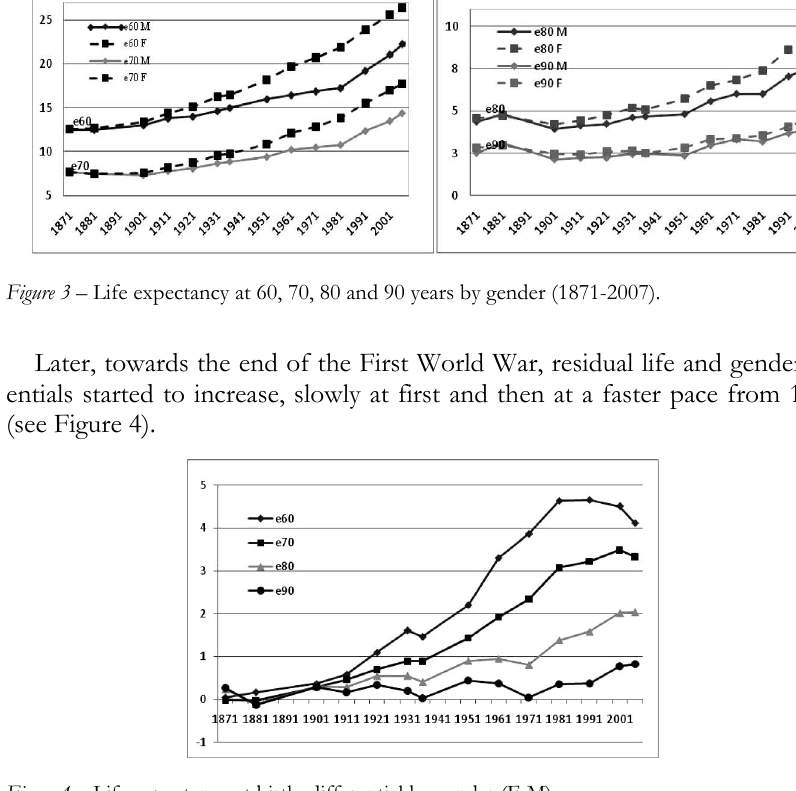
Figure 4 – Life expectancy at birth, differential by gender